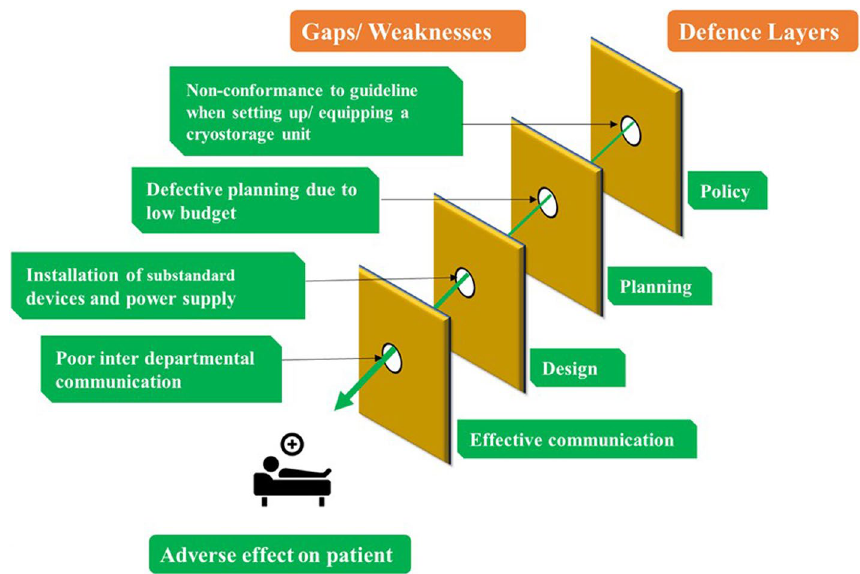
Fig. 2 Reason’s Swiss Cheese Theory of Error [27]. The bars represent an organization’s defences against failures and the holes represent weaknesses in the defences. A patient experiences an adverse event only when all the holes in the defensive layers align to allow these errors trajectory to eventually reach the patient. These weaknesses in the clinic’s policy, planning, building design, and inter-departmental communication are responsible for the adverse event experienced by the